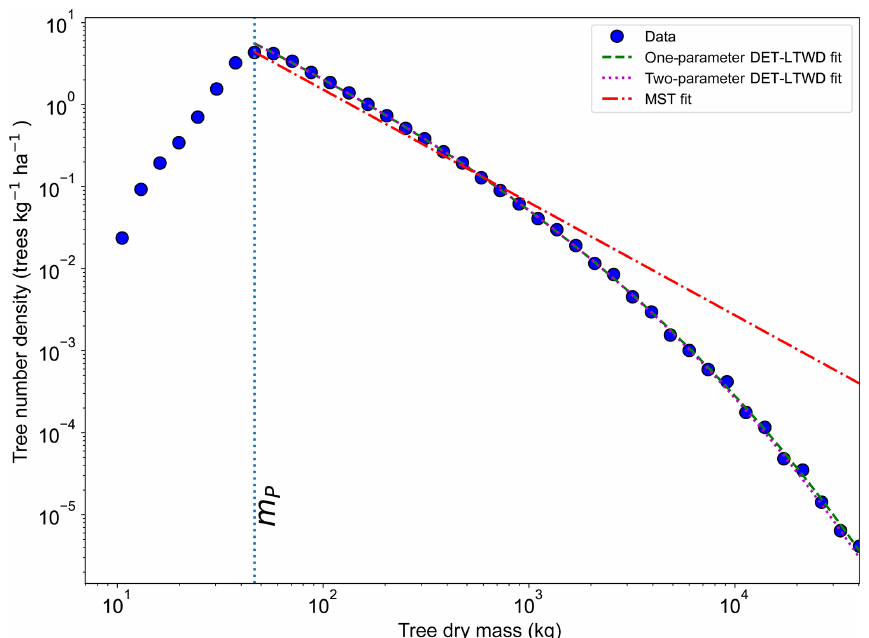
Figure 6. Fit to the mass size distribution for all South American RAINFOR plots as one large dataset. The blue circles show the binned data and the lines show the fitted distribution for each model. The peak in the distribution is clearly shown. The fitting is only performed on trees with mass greater than the mass of the peak. Table 4. Results of fitting the models of the mass size distributions for the forest plot data aggregated to regions, countries and all plots combined. Shown are the fitted parameters for each model. m P refers to the point at which all data with smaller mass were excluded to remove the allometry conversion artefact. Biomass is the tree dry mass density of all trees with dry mass above m P . Region No. of trees Area (ha) m P (kg) Biomass (kgm − 2 ) DET one parameter DET two parameters µ m1 µ m1 φ m All S.